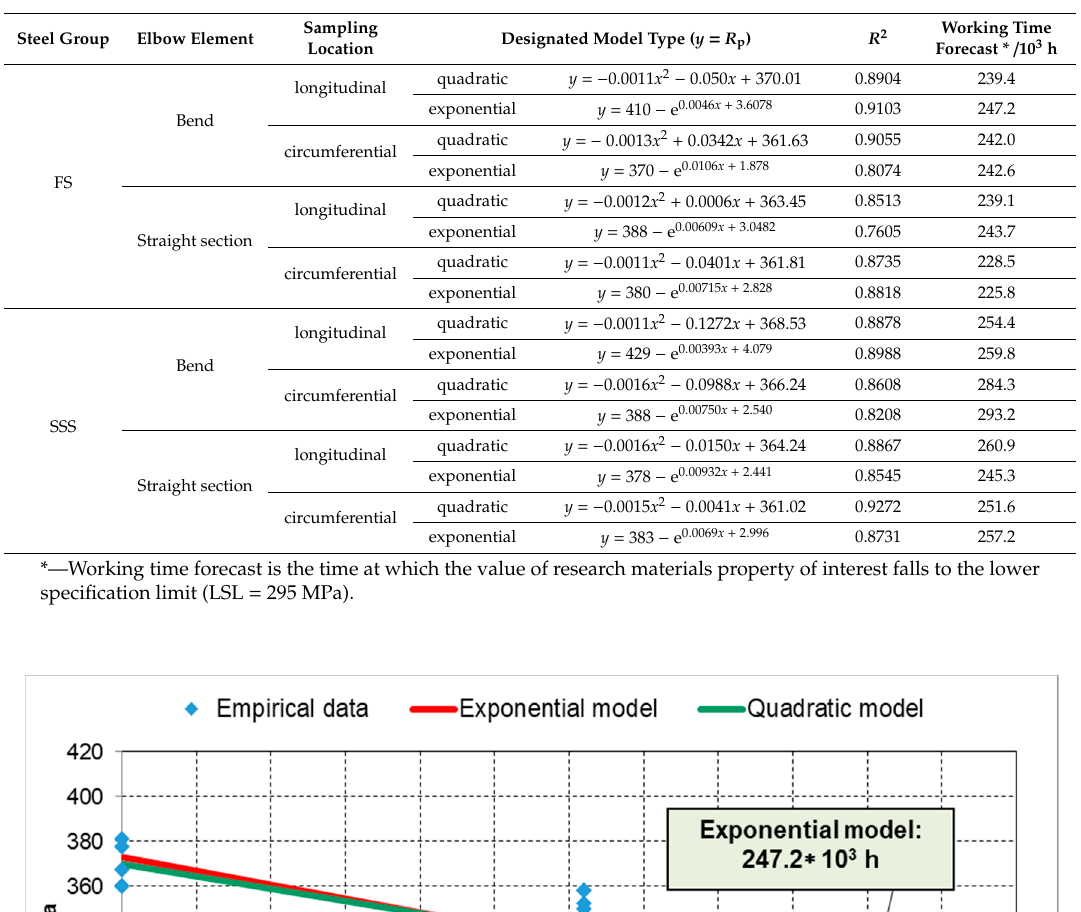
Table 4 . Summary set of prognostic models of R p for FS and SSS steel groups designated.